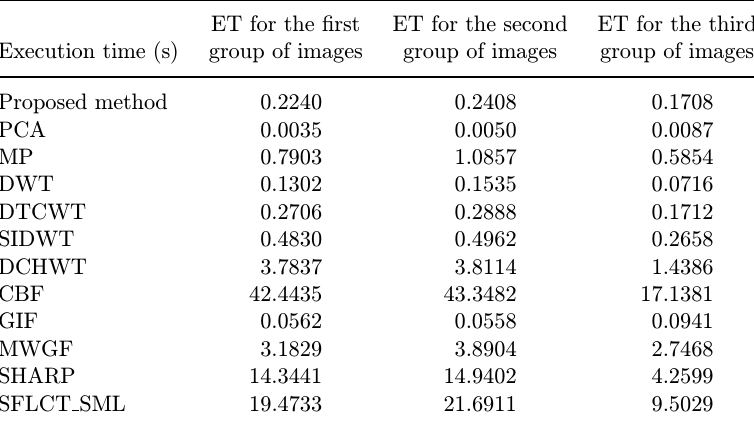
Table 4. Computational e±ciency for the three groups of medical images.